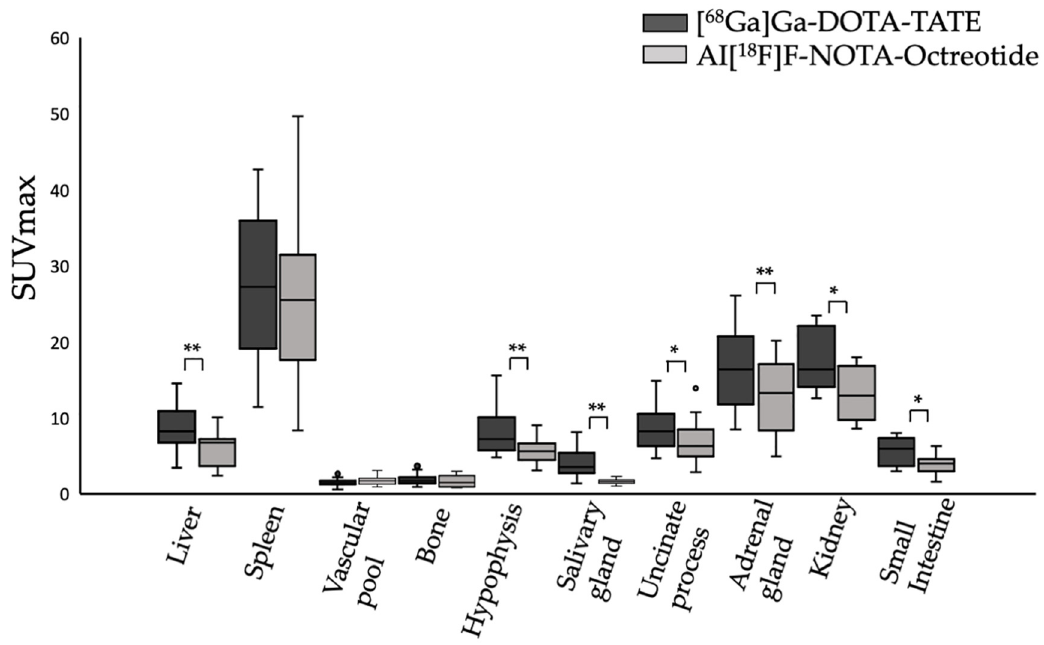
Figure 1. Physiological uptake (SUVmax) of [ 68 Ga]Ga-DOTA-TATE (black bars) and Al[ 18 F]F-NOTA-Octreotide (grey bars) in different tissues. * ( p < 0.05), ** ( p < 0.001). Tumour uptake of [ 68 Ga]Ga-DOTA-TATE and Al[ 18 F]F-NOTA-Octreotide was com- pared by means of SUV max values and tumour-to-background ratios. [ 68 Ga]Ga-DOTA-TATE showed higher uptake in liver (SUVmax: 8.76 ± 2.84 vs. 6.11 ± 2.24), hypophysis (SUVmax: 8.12 ± 3.05 vs. 5.75 ± 1.68), salivary glands (SUVmax: 4.1 ± 1.83 vs. 1.68 ± 0.29), uncinate process (SUVmax: 8.58 ± 2.91 vs. 6.82 ± 2.73), adrenal glands (SUVmax: 16.42 ± 4.8 vs. 12.75 ± 4.65), kidneys (SUVmax: 17.64 ± 4.01 vs. 13.41 ± 3.63) and small intes- tine (SUVmax: 5.73 ± 1.78 vs. 3.9 ± 1.33) as compared to Al[ 18 F]F-NOTA-Octreotide. (Figure 1, Table